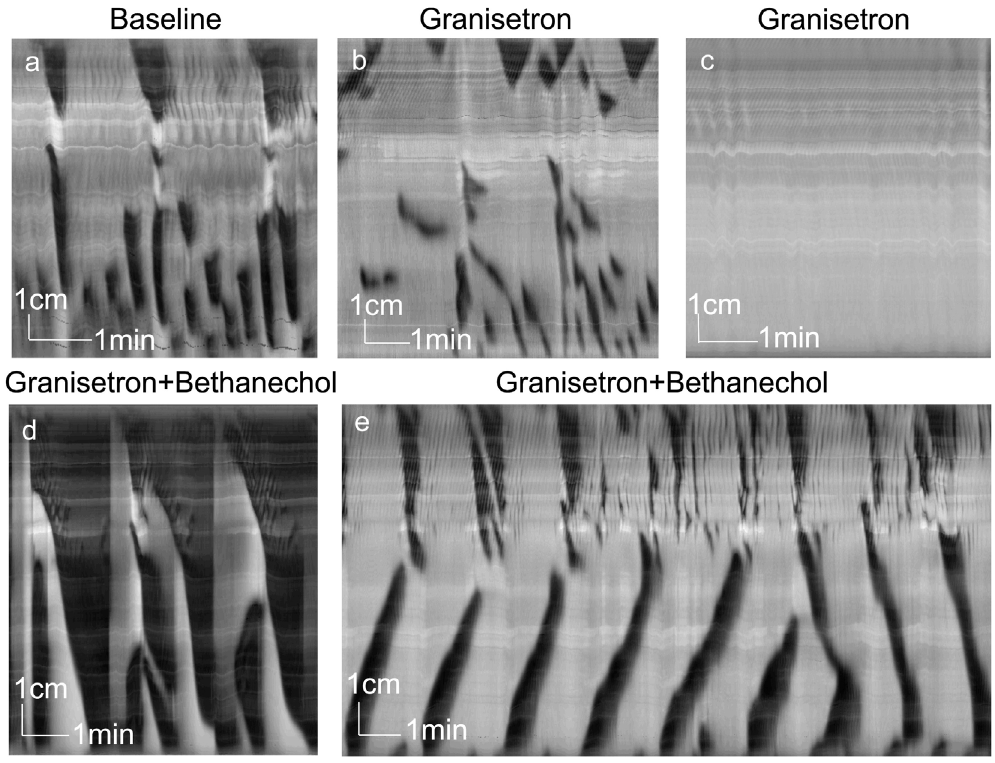
Figure 6. Effect of the 5-HT 3 antagonist granisetron. Spatiotemporal maps created from video recordings of motor patterns of the whole rat colon. a. Control activity consisted of a tandem contraction and two interrupted LDCs accompanied by distal antegrade RPMCs (rat 1). b. After addition of granisetron (3.8 6 10 2 6 M, added 30 min before start of panel b), LDC activity was abolished, RPMCs were disrupted and segmentation activity was induced in the mid and distal colon (rat 1). c. LDCs and related motor patterns were abolished 20 min after addition of granisetron (3.8 6 10 2 6 M, rat 2) for a period of 5 min, thereafter segmentation activity emerged (not shown).d. In the presence of granisetron, bethanechol (2 6 10 2 6 M, added 10 min before start of trace), evoked rhythmic LDC- like pan-colonic propulsive contractions with mid- and distal colon antegrade and bi-directional contractions (rat 2). e. Rhythmic retrograde contractions in distal colon became dominant after 30 min in the presence of granisetron and bethanechol (2 6 10 2 6 M, added 20 min before start of trace) (rat 2).